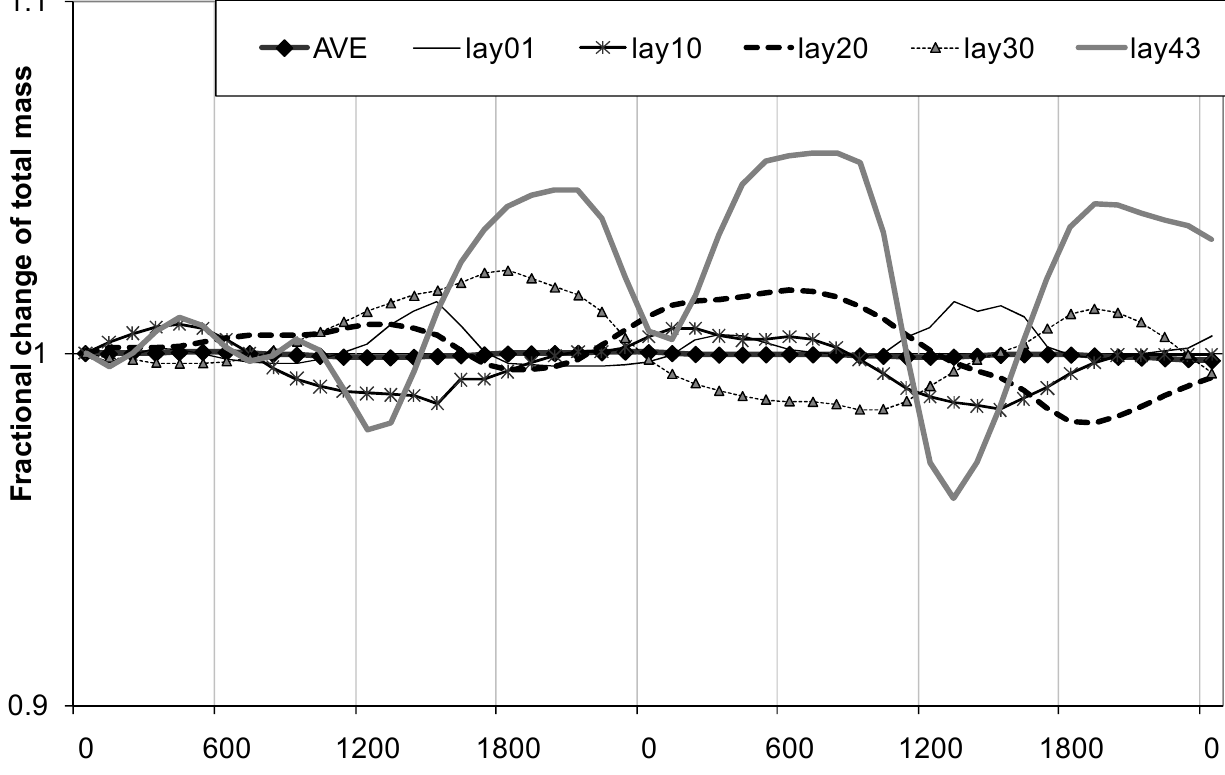
Figure B1. Time series of mass summed over different layers: (01), (10), (20), (30), (43), and domain-wide total (AVE) for a Houston-centered Lambert Conformal Conics grid in 4km horizontal grid spacing with a total West-to-East traverse of 330 km and a South-to-North traverse of 240 km, between 00 UTC 27 August and 00 UTC 28 August,